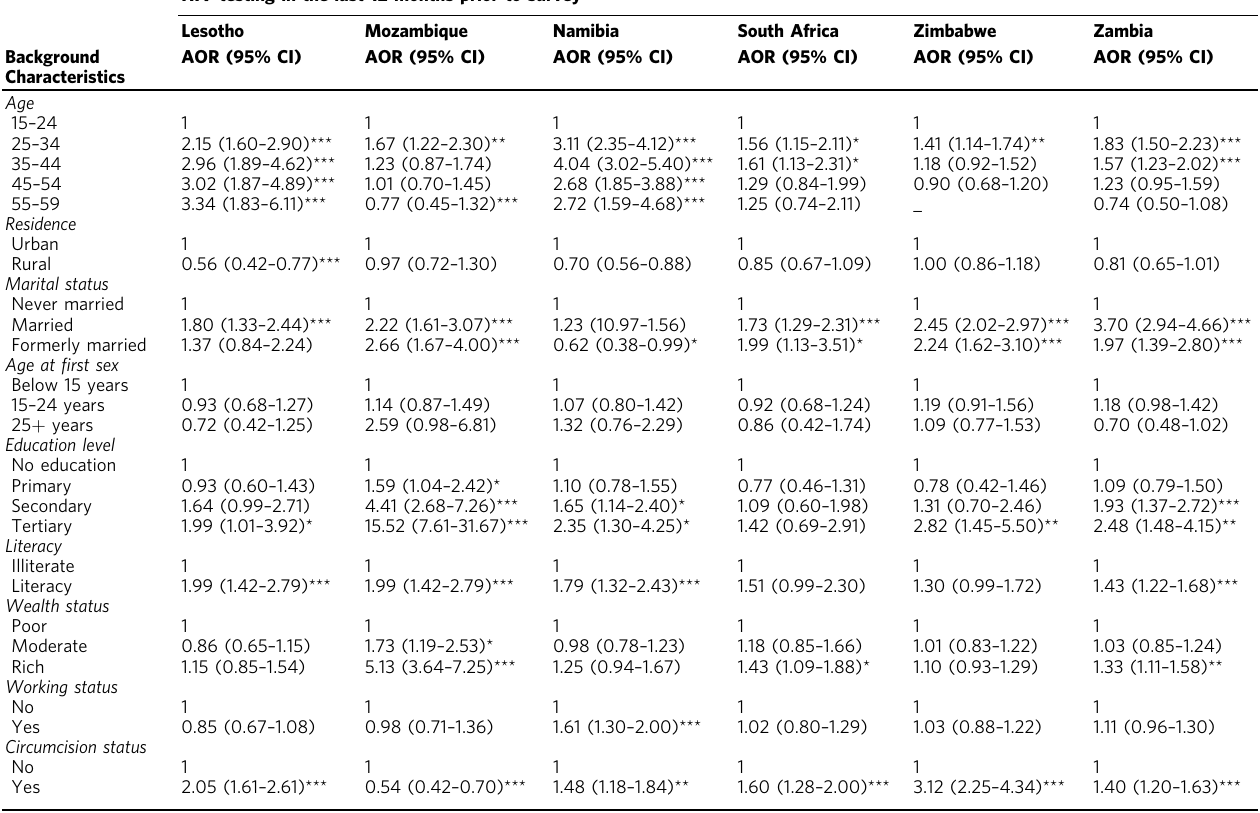
Table 6 Results of multivariate analyses examining the effect of individual-level factors on HIV risk behaviour among men by country in Southern Africa